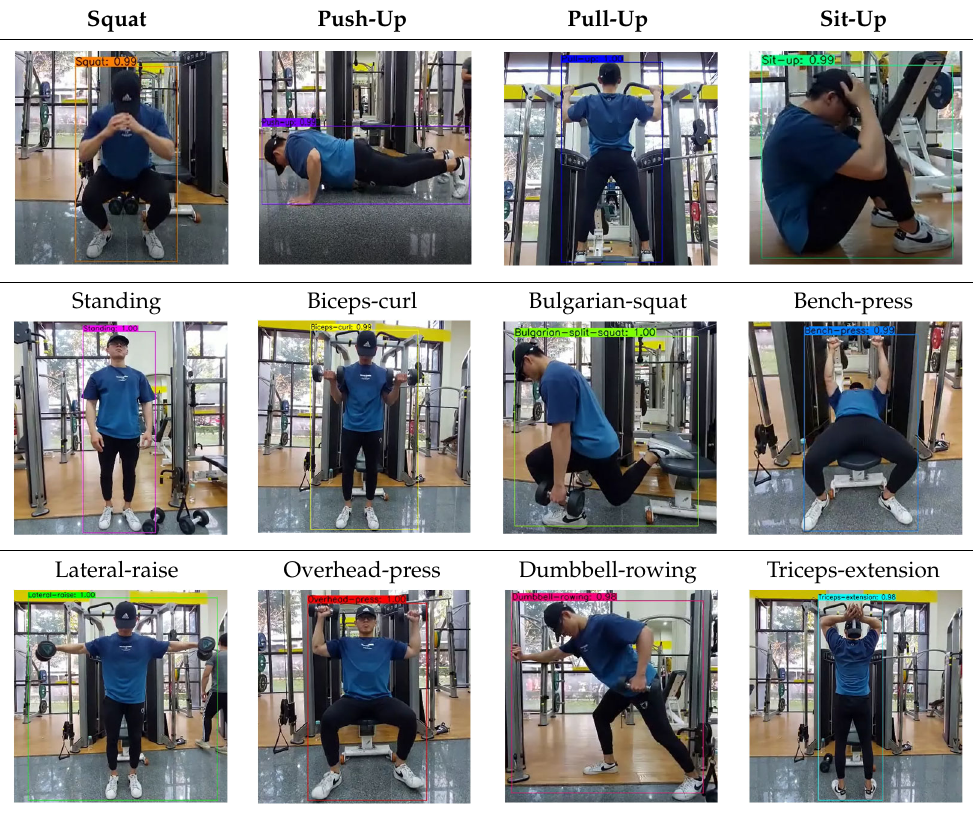
Table 9. Result of Yolov4 detecting fitness type.